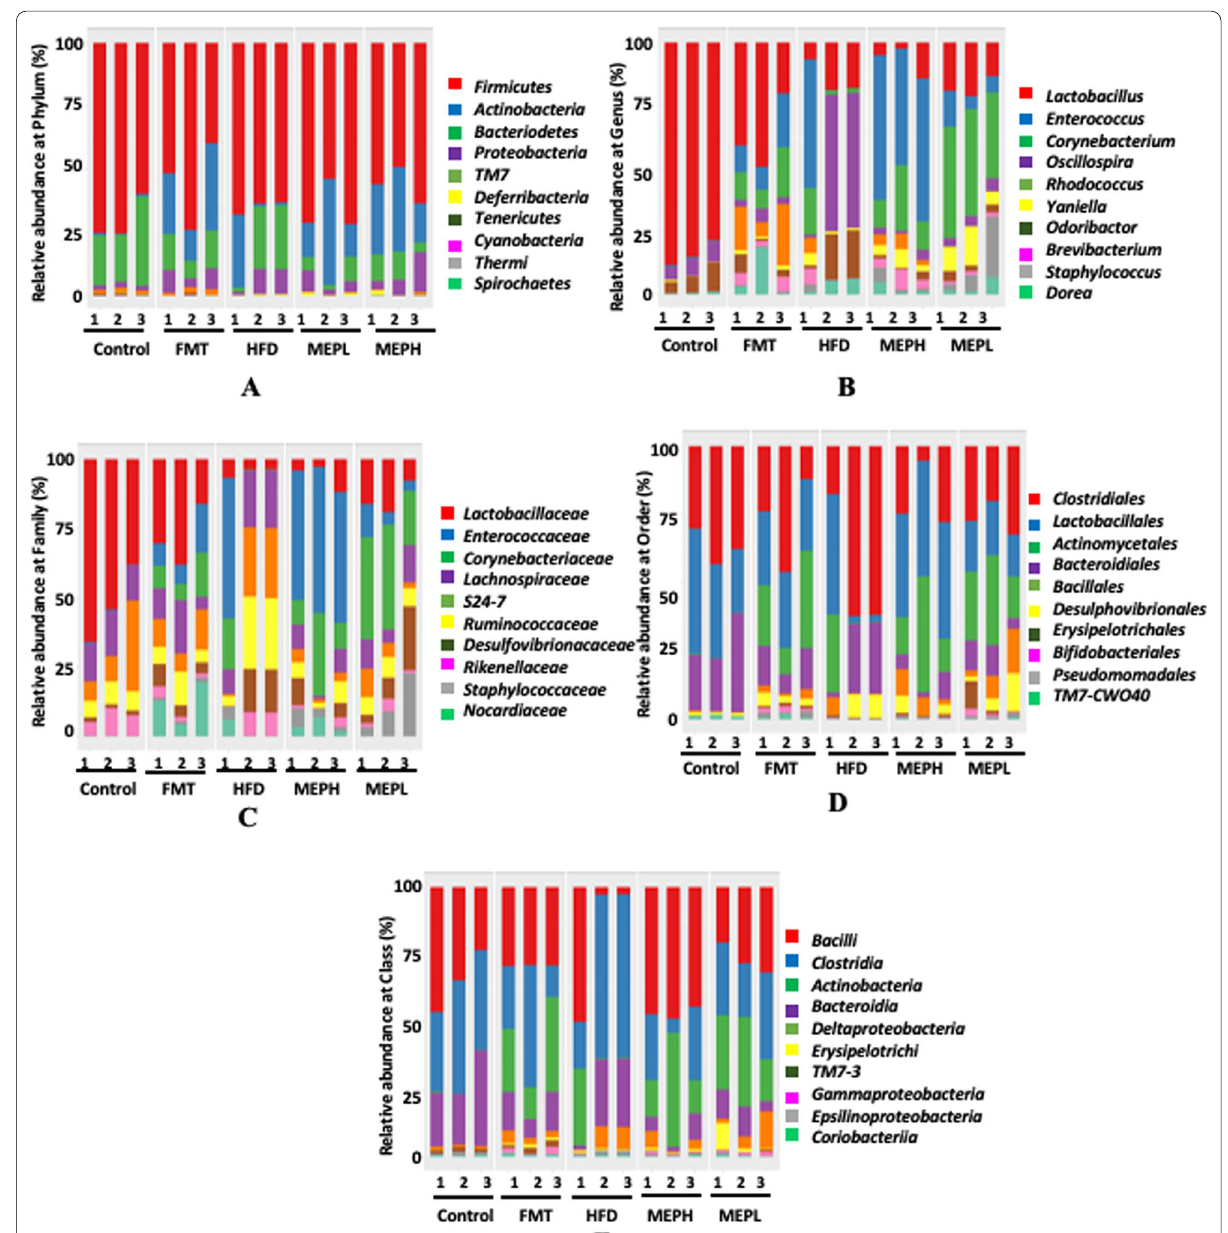
Fig. 9 Bacterial composition at different taxonomy levels in HFD-induced obese mice. Relative abundance per cent (%) at A Phylum level, B Genus level, C Family level, D Order level, and E Class level, Enterococcus, Lactobacillus, Corynebacterium, Rhodococcus and Oscillospira were found in